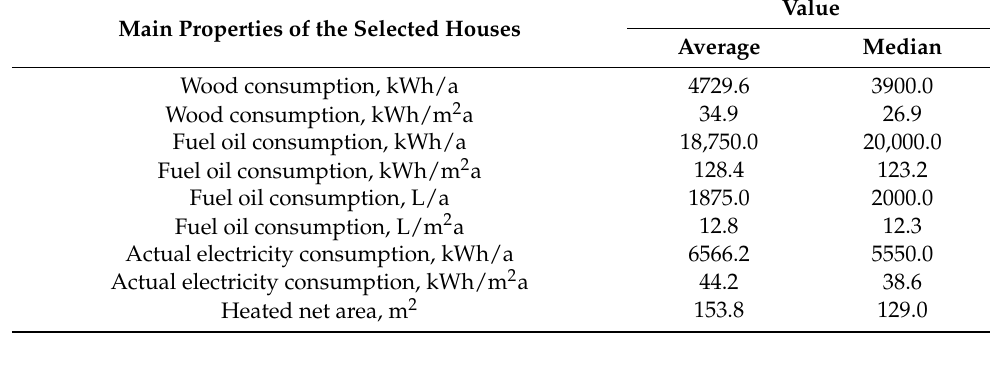
Table 1. Composed energy consumption of reference houses (selection of 1970s houses (N = 74)). Main Properties of the Selected Houses